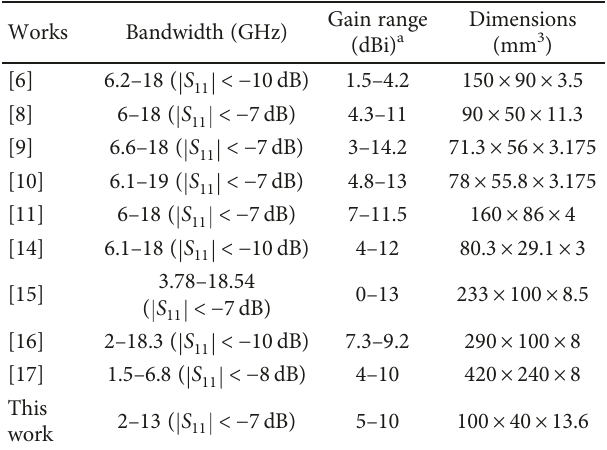
Table 1: Units for magnetic properties.